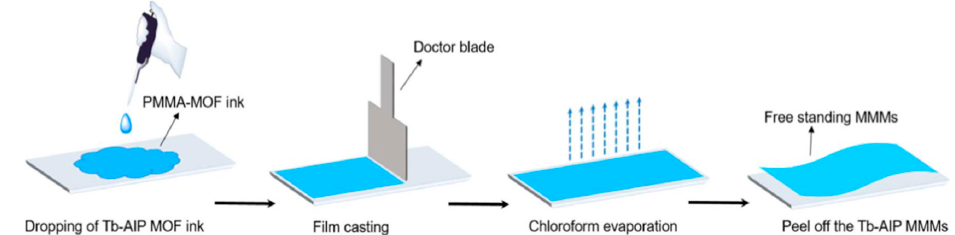
Figure 26. Schematic illustration for the preparation of Tb-AIP MMMs. Reprinted with permission from Reference [125]. Copyright 2017 WILEY-VCH Verlag GmbH & Co., (Weinheim, Germany).